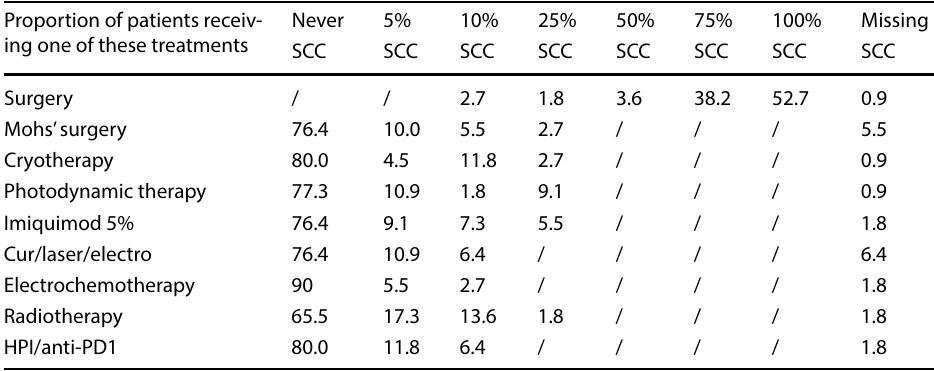
Proportion of patients receiv- ing one of these